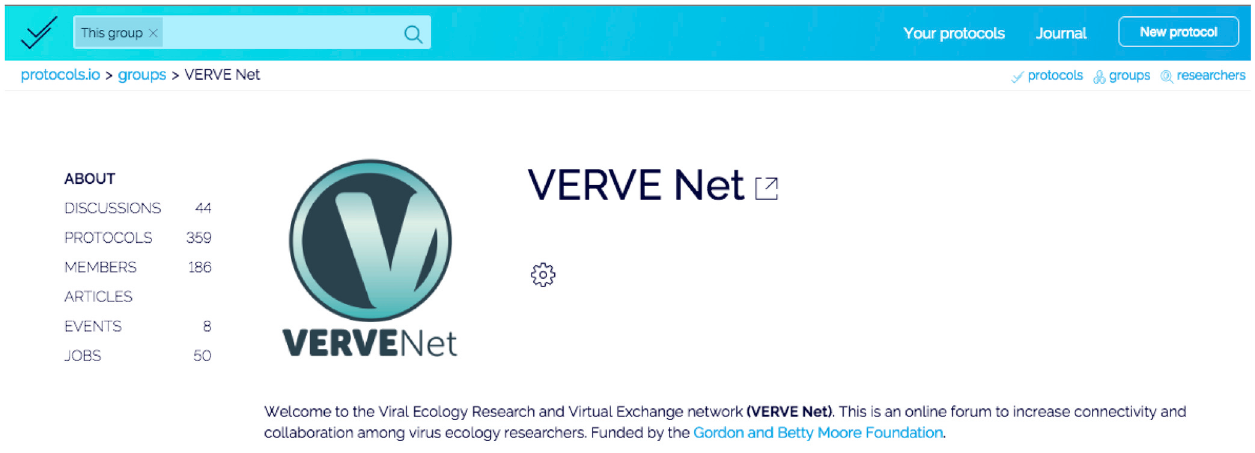
Figure 2. The VERVENet group in protocols.io. Groups in protocols.io display information about the group objectives, members, subgroups, the group library and literature recommendations, group discussions, news, jobs, and events. Groups have the capacity to control access, from making groups and content public and allowing anyone to join, to restricted content and invitation only membership. VERVENet is an example of a public forum for